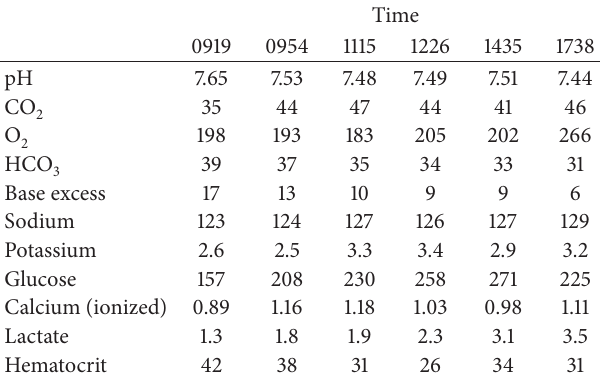
Table 1: Intraoperative laboratory